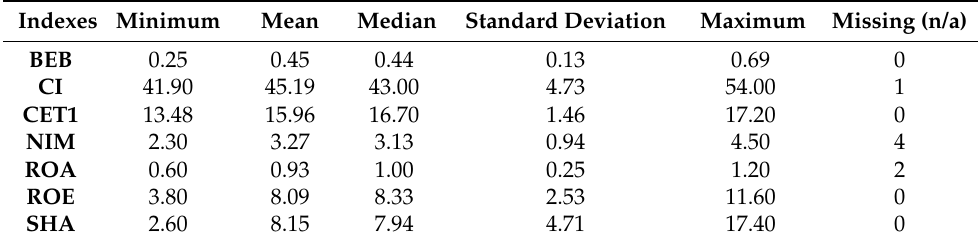
Table 6. The descriptive statistics for the BEB index and financial indicators